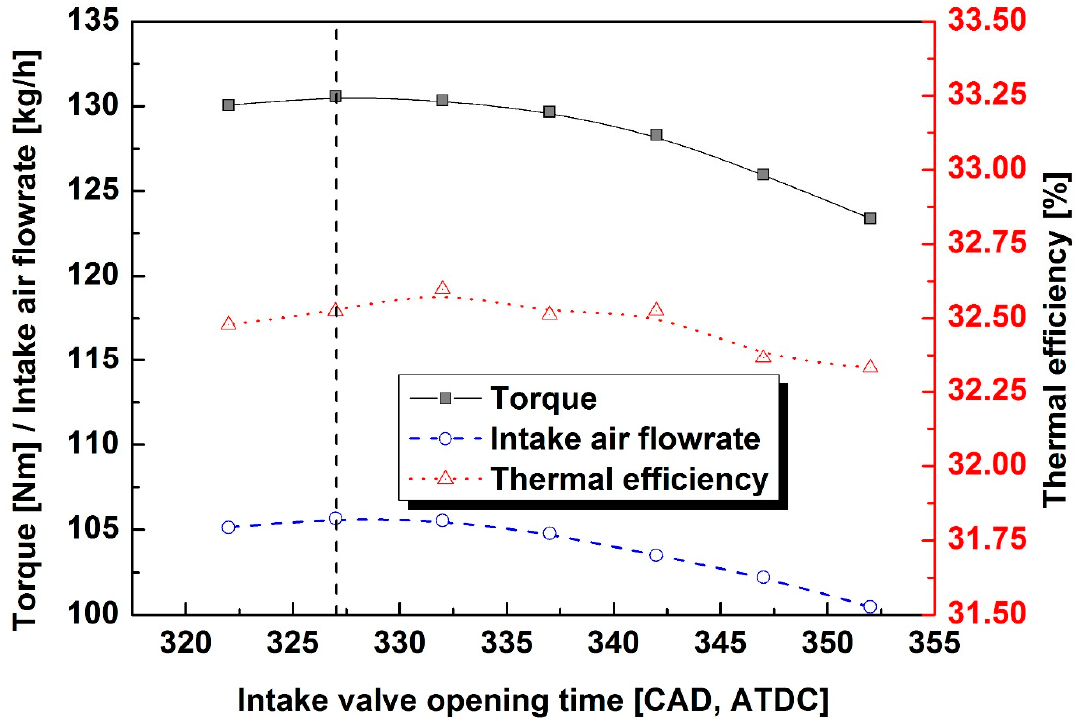
Figure 5. Torque, intake airflow rate, and thermal efficiency variations with intake valve opening time change at constant exhaust valve opening time of 161 CAD ATDC and excess air ratio of 1.25. Table 4. Simulation results of residual gas fraction changes for each intake and exhaust valve timing at the excess air ratio of 1.25 with commercial one-dimensional (1D) simulation software (WAVE, Ricardo